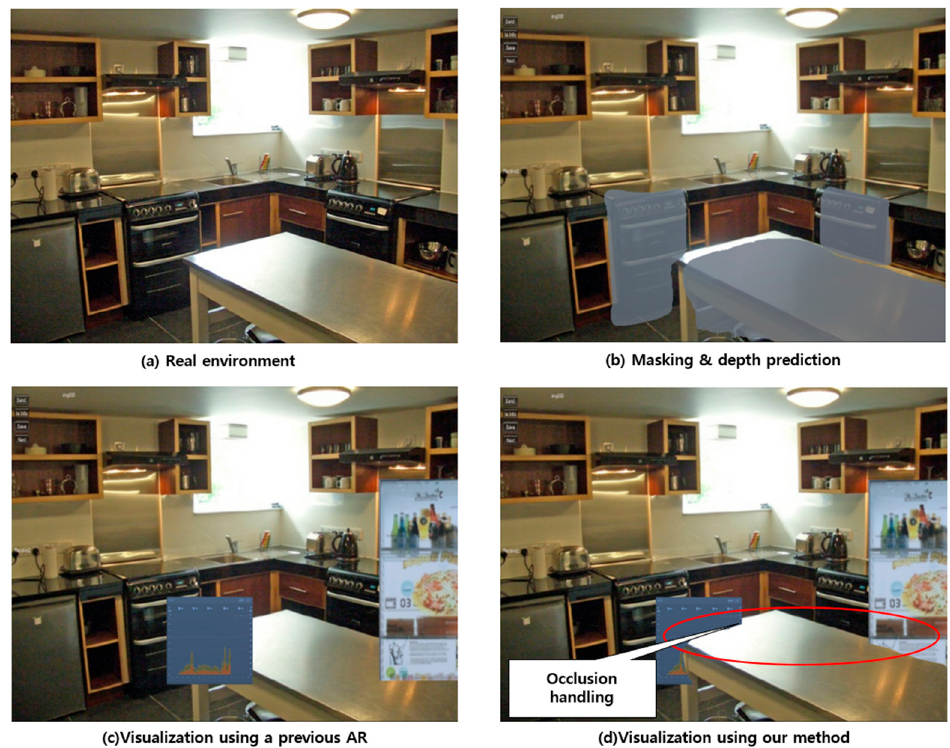
Figure 17. Application of the proposed approach to IoT visualization in a smart home.